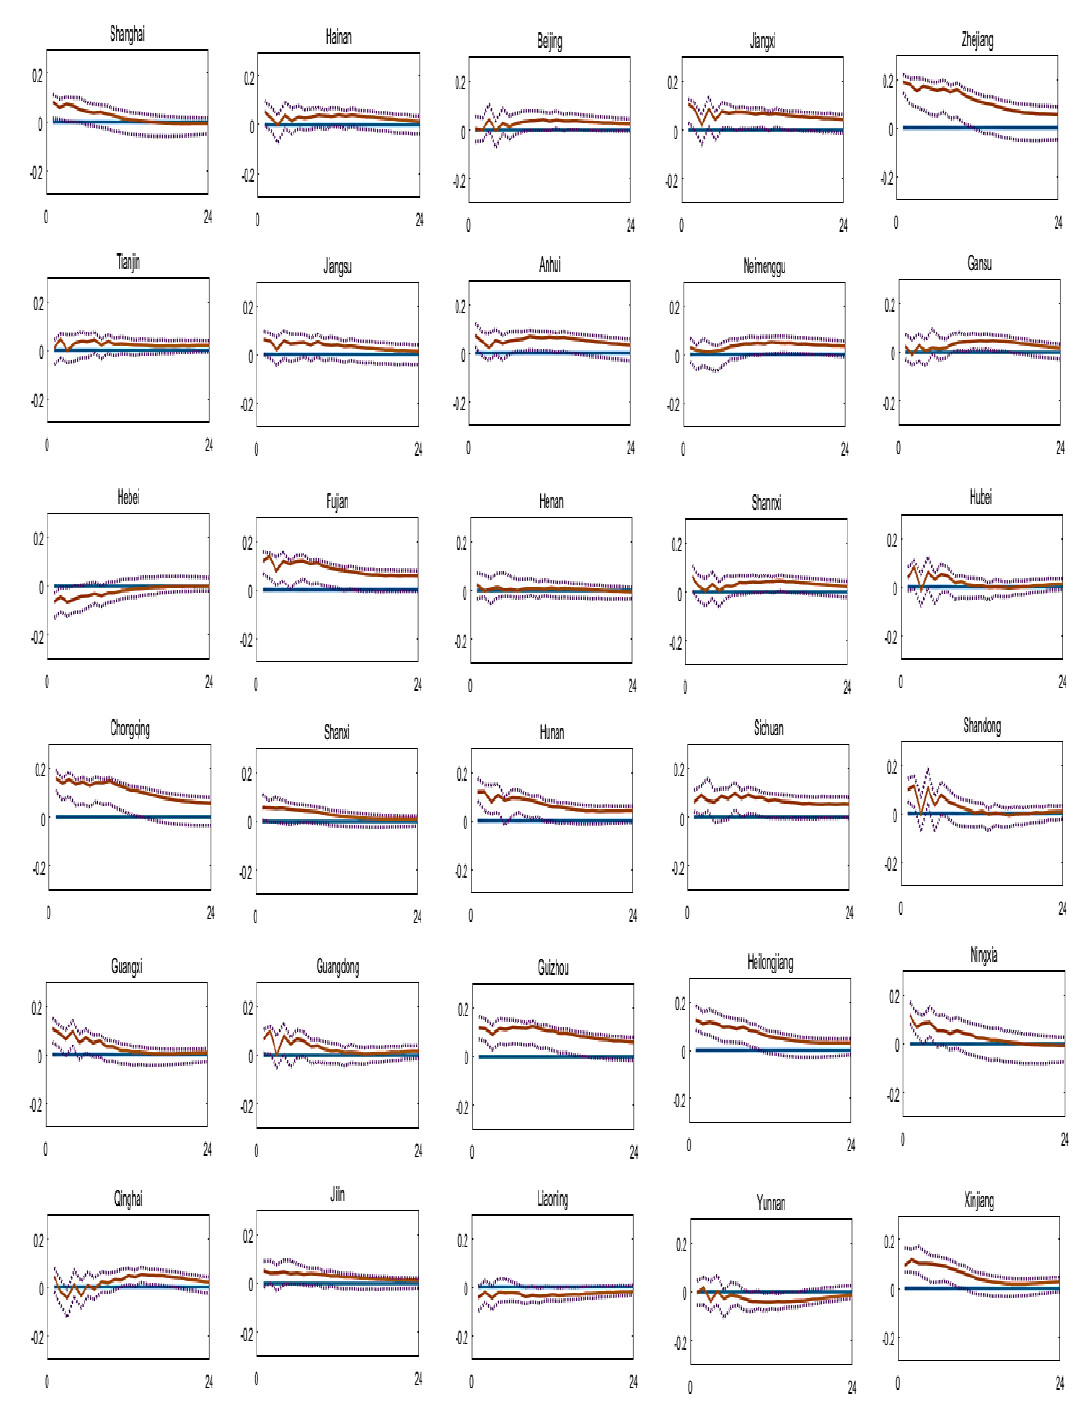
Figure A2. Impulse response of house prices to one standard error shock to M2: FAVAR system with three factors.